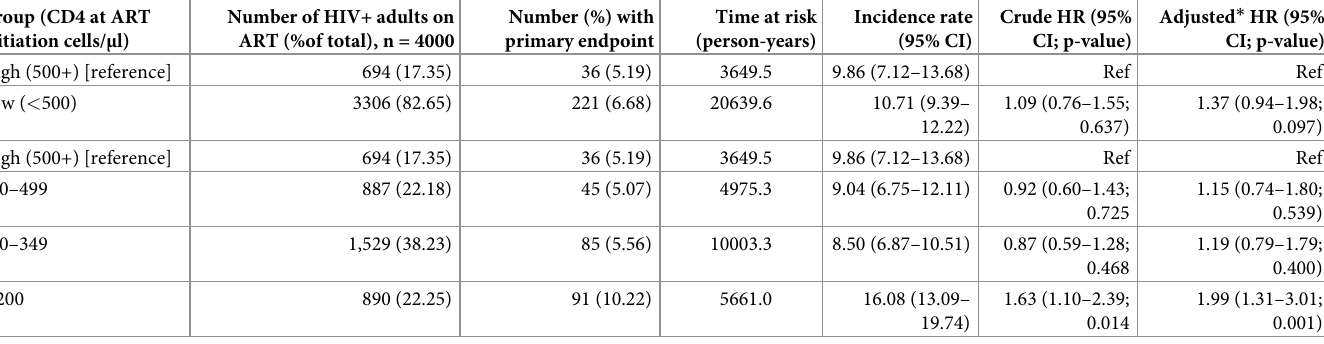
Table 3. Results of a univariable and multivariable Cox models for the hazard of the primary endpoint (serious AIDS, serious non-AIDS or death from any cause). Group (CD4 at ART initiation cells/ μ